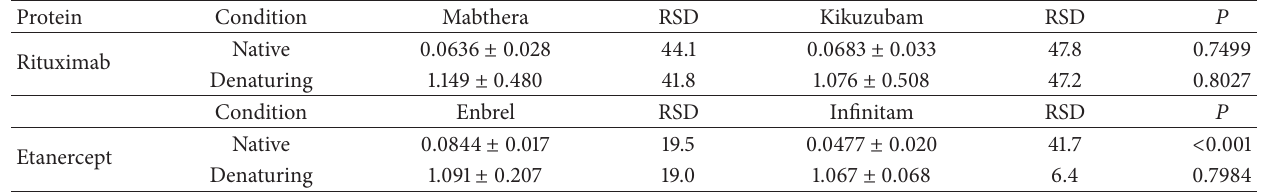
Table 3: Thiol quantification using DLM method. Rituximab and Etanercept free thiols under native and denaturing conditions using DLM method. Dispersion values are presented in SD ( 𝑛 = 9 ).